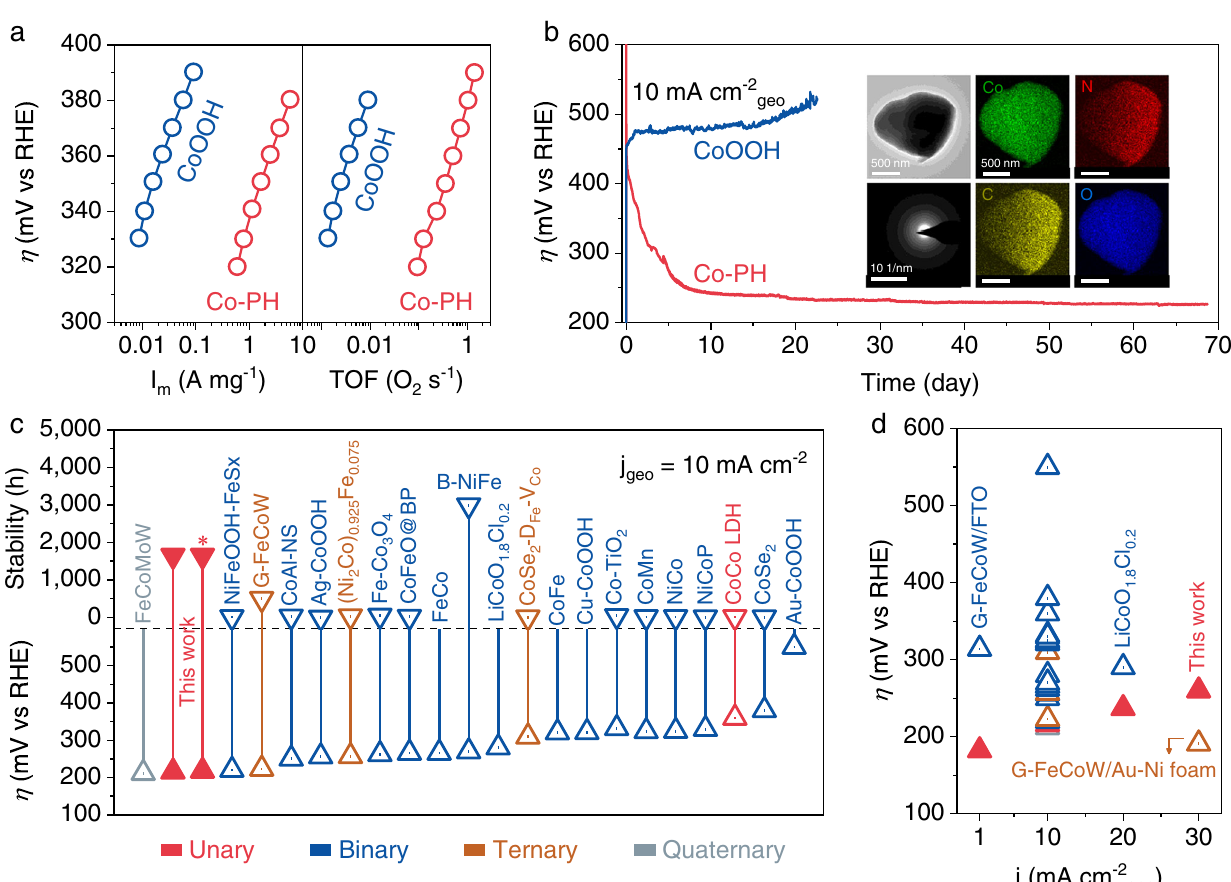
mapping (EDX) images of Co-PH after the stability test. c The activity and stability comparisonofmulti-metalCo-based catalysts withoursingle-metalCo-PH catalyst at10mAcm − 2 geo . The overpotential of Co-PH at10mAcm − 2 wasobtainedfrom the stabilitytestinFig.6b.*Notingthattheoverpotentialandstabilitywereobtainedat 10mAcm − 2 ECSA . d The activity comparison of the above catalysts at different cur- rent densities (more details in Supplementary Table